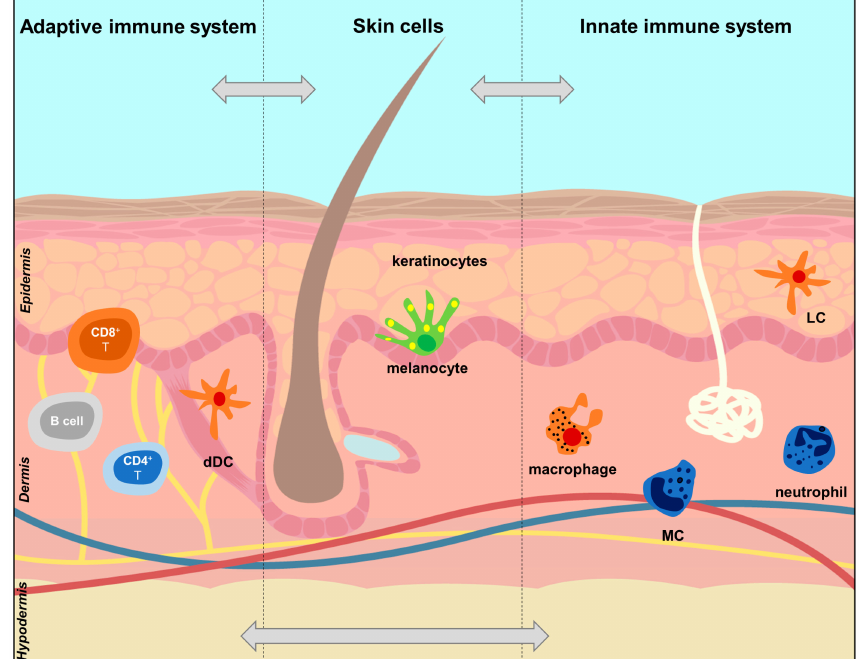
Figure 1. Location of key cells of the innate and adaptive immune systems in the skin. The figure shows the main participants in the innate immune system (IIS) and adaptive immune system (AIS) in the epidermis and dermis. The cells of the IIS have pattern recognition receptors (PPRs) on their surface. Once these are activated, the cells shown in orange (LCs, Langerhans cells, and dDCs, dermal dendritic cells) acquire potent antigen-presenting capacities (APCs) and produce proinflammatory cytokines. The activated orange cells also drive the di ff erentiation of T cells into Treg, Th1, Th2 and Th17 which are part of the AIS [16,25]. Additionally, the APCs also control the influx of neutrophils through the production of TNF and with the help of mast cells (MCs) [25]. Keratinocytes and melanocytes produce autoantigens that are involved in the activation of IIS cells and subsequent di ff erentiation of T cells. Keratinocytes are particularly important in skin immunity, interacting with cells of the IIS and